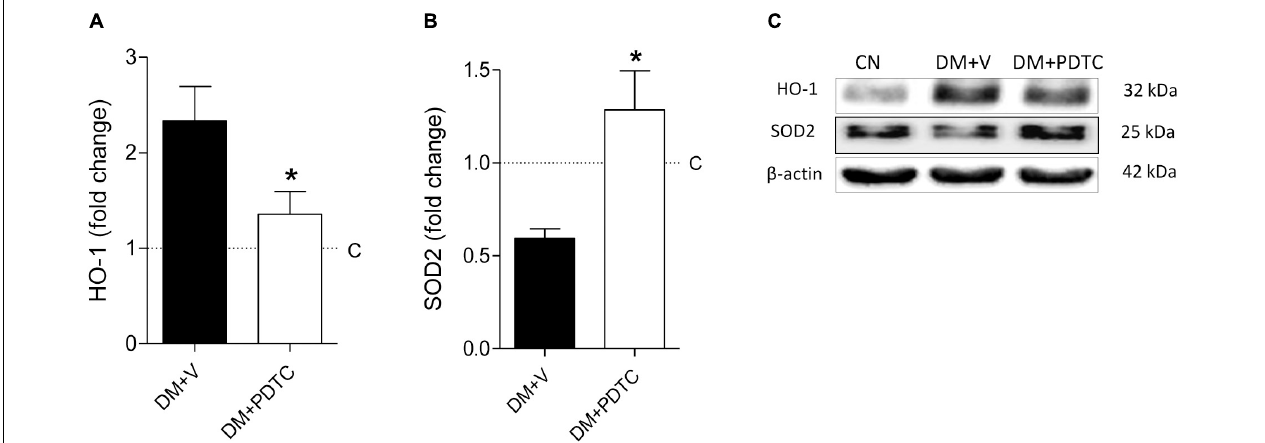
FIGURE 7 | Renal cortical abundance of (A) heme oxygenase-1 (HO-1) and (B) superoxide dismutase 2 (SOD2), quantified by Western blot analysis (C) in rats treated with the NF- κ B inhibitor pyrrolidine dithiocarbamate (Group DM+PDTC, n = 11) or vehicle (Group DM+V, n = 16) at 12 months of DM. The values obtained from the groups DM+V and DM+PDTC were factored by age-matched controls rats (C, horizontal dotted lines). Results expressed as means ± SE. * p < 0.05 vs. DM+V.